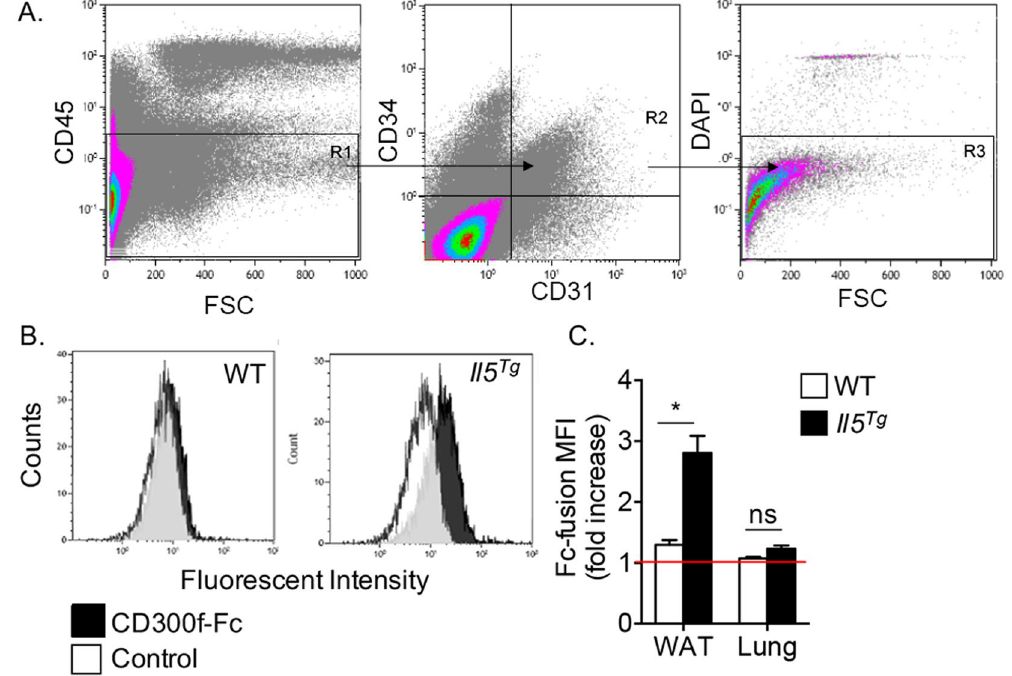
Figure 5. Viable adipose tissue endothelial cells express a CD300f ligand. White adipose tissue ( A – D ) and lungs ( D ) from wild type (WT) and Il5 Tg mice were obtained, enzymatically digested and stained with viability and endothelial cells markers ( A ). Thereafter, the binding of CD300f-IgG1 Fc fusion protein to viable adipose tissue ( B , C ) and lung ( D ) endothelial cells was determined by flow cytometry. Data are representative of n = 4 independent experiments; * p < 0.05, ns- non-significant as analyzed by Student’s t-test ( C